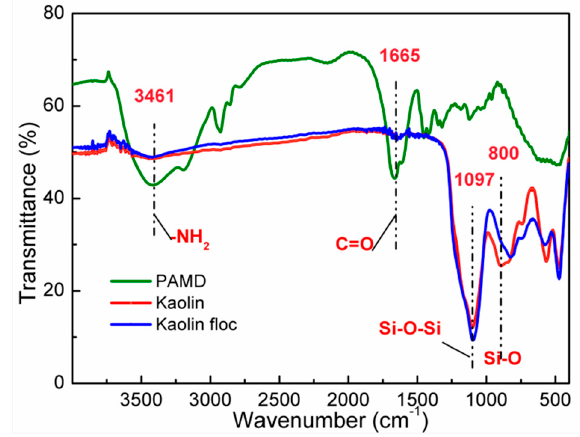
Figure 10. FTIR comparison of PAMD, kaolin, and flocs. FTIR: Fourier transform-infrared.